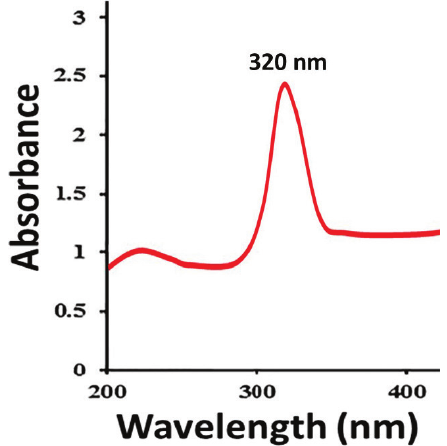
Figure 1: UV-Visible spectrum of ZnO NPs.